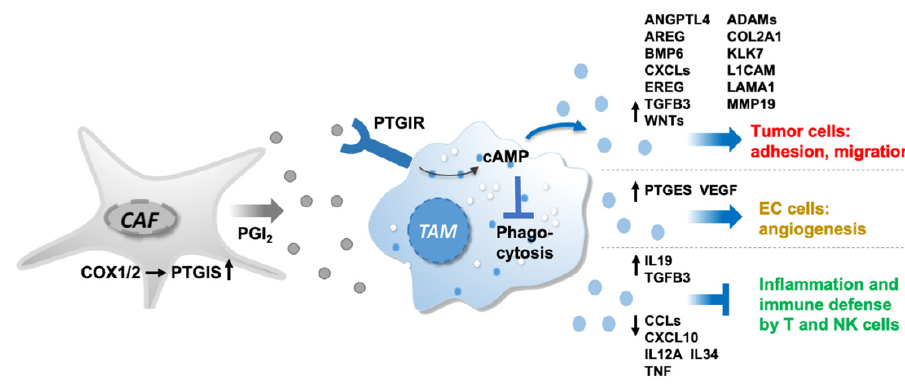
Figure S5: PGE2 synthesis in different cell types of the HGSC TME; Figure S6: Validation of PT- GIR staining in macrophages; Figure S7: PTGIR expression in differently polarized macrophages; Figure S8: Induction of PTGIR signaling by different PGI2 analogs; Figure S9: Impact of PGI2 analogs on macropinocytosis in differently polarized macrophages; Figure S10: Influence of CAF on macropinocytotic activity of TAM; Figure S11: Original immunoblots (full blots). Original images of immunoblots; Table S1: Ovarian HGSC patient data and samples; Table S2: RT-qPCR primers; Table S3: List of enzymes involved in the synthesis lipid ligands and cognate receptors; Table S4: Expression of genes coding for enzymes involved in the synthesis lipid ligands; Table S5: Expression of genes coding for receptors of lipid ligands; Table S6: Genes regulated in TAM by MRE-296 versus solvent control; Table S7: Genes upregulated in TAM by MRE-296 versus solvent control; Table S8: Genes downregulated in TAM by MRE-296 versus solvent control; Table S9: Pathways annotation (ConsensusPathDB) of MRE-regulated genes in Table S6 (top hits by FDR) in Reactome, KEGG and Wikipathways databases; Table S10: Genes upregulated in